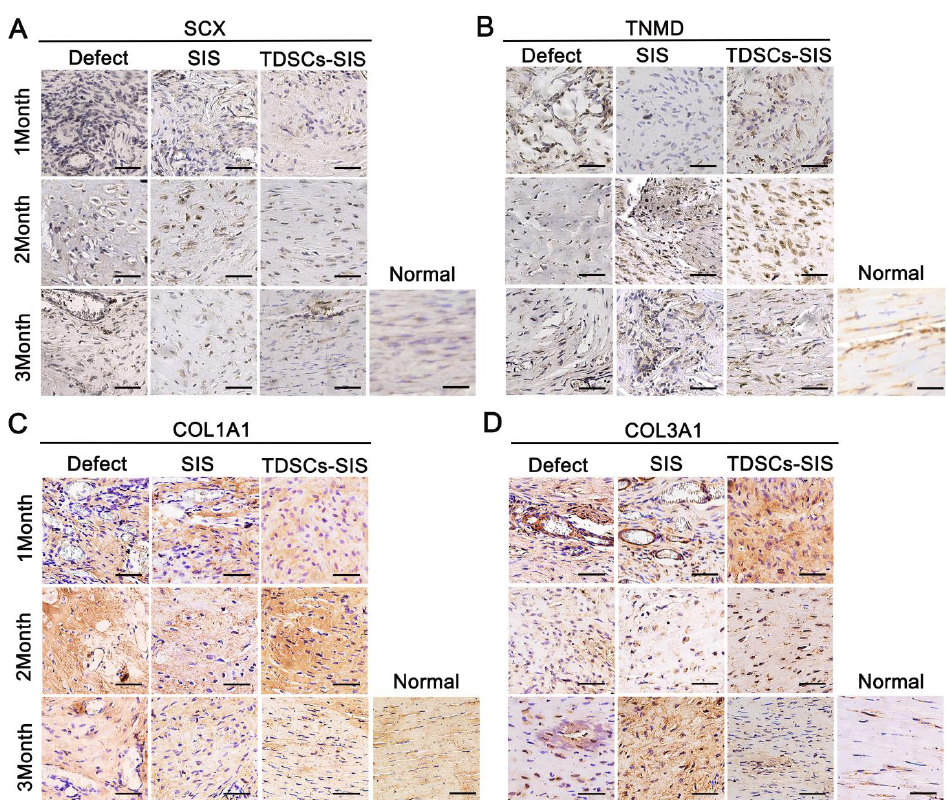
Figure 6. TDSCs – SIS scaffold facilitated Achilles tendon regeneration. ( A , B ) Expression of SCX and TNMD was evaluated at 1, 2, and 3 months by immunohistochemistry assay. ( C , D ) Expression of the extracellular-matrix-related factors COL1A1 and COL3A1 were evaluated after TDSCs – SIS scaffold treatment at 1, 2, and 3 months. Bar: 50 μm .